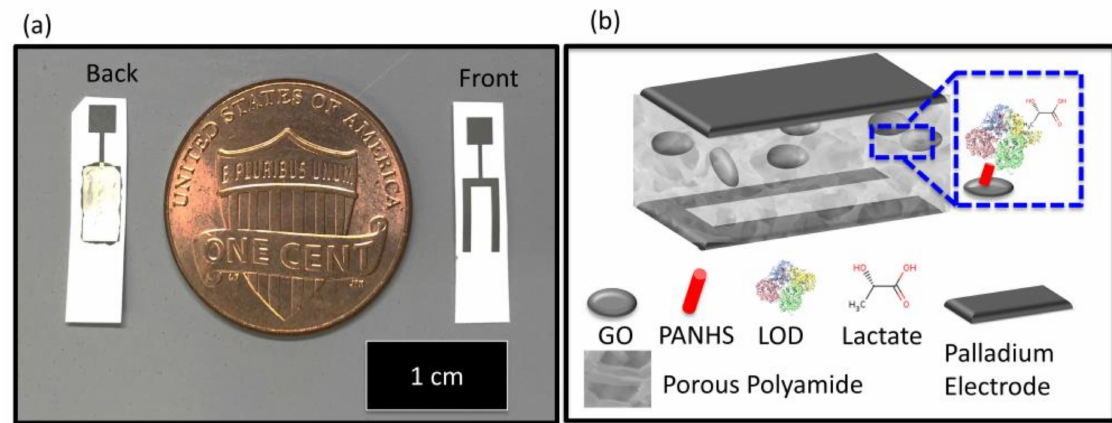
Figure 26. ( a ) Lactate sweat sensor optical visualisation. ( b ) The electrochemical affinity-based lactate detection technology using graphene oxide across a membrane is shown schematically. (Reproduced from [556] with permission. Copyright 2020, Elsevier, Amsterdam, The Netherlands).